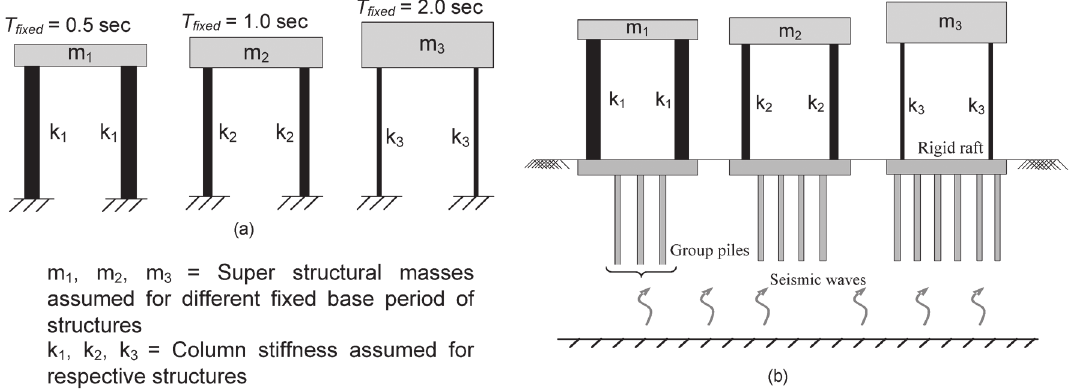
Fig. 1. Schematic diagram of the idealized system considered: a) fixed base system; b) the SSI